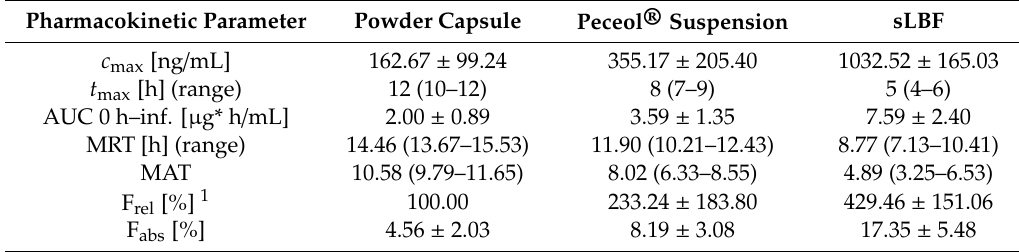
Table 6. Pharmacokinetic parameters of oral administration of 100 mg / pig venetoclax in male landrace pigs. Venetoclax was administered as a powder capsule, a Peceol ® suspension, and a supersaturated Peceol ® solution (sLBF) (n = 3, except sLBF, where n = 2). t max and MRT are given as median (range), all other parameters as the mean ±